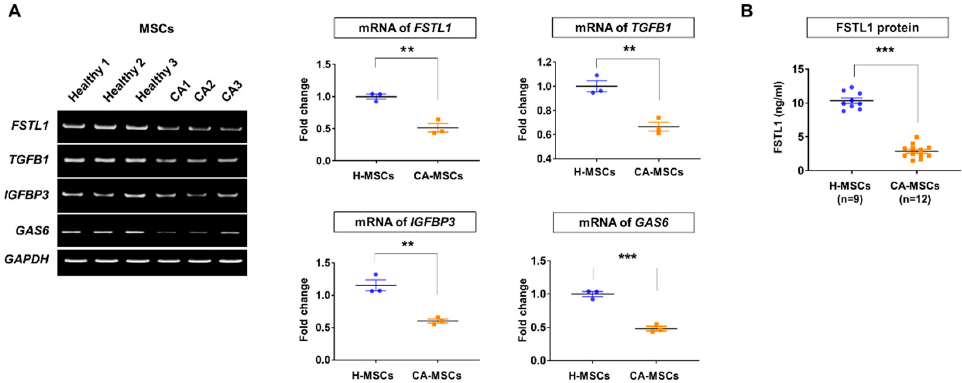
Figure 5. Validation of the secretome analysis results. ( A ) Validation of the identified proteins in secretome analysis according to mRNA expression by reverse transcription polymerase chain reaction. ( B ) Protein validation of FSTL1 in the conditioned media of mesenchymal stem cells (MSCs) derived from H-MSCs ( n = 9) and MSCs derived from cerebellar ataxia patients (CA-MSCs) ( n = 12). Data are presented as mean ± SEM. Comparisons of the two groups were carried out using an unpaired two-tailed t -test. ** p < 0.01, *** p < 0.001 vs.